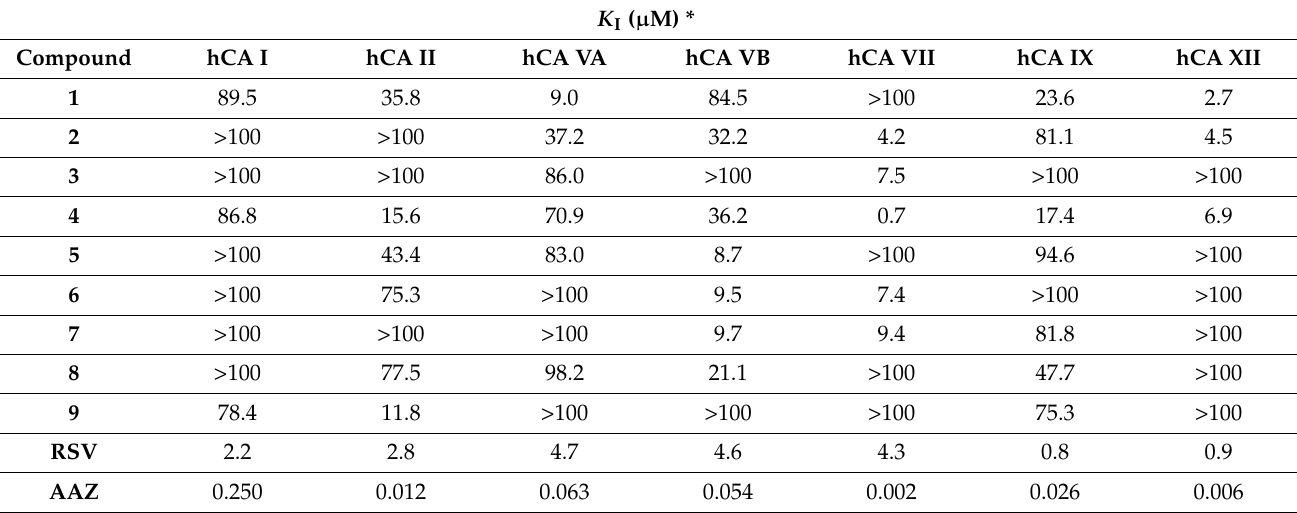
Table 2. The K I values for the inhibition of hCA I, II, V, VII, IX, and XII by derivatives 1 – 9 , RSV, and AAZ as reference inhibitor.